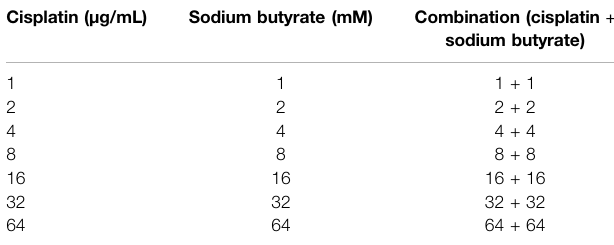
FIGURE1| EvaluationofGC cells ’ growthinhibitioninducedbycisplatin and/or sodium butyrate by CCK-8 kit. (A) (a) GC cells (HGC-27, SGC-7901 and MGC-803) were treated with cisplatin (0, 1, 2, 4, 8, 16, 32, and 64 µg/ml) or sodium butyrate (0, 1, 2, 4, 8, 16, 32, and 64 mM) for 24 h. (b) Cell Counting Kit-8 assays showed that HGC-27 cells and SGC-7901 cells were more sensitive to sodium butyrate. (c) GES-1 cells were treated with the different concentrations of cisplatin or sodium butyrate as described above and acombinationofcisplatin andsodium butyrate for24 h. (B) HGC-27 cells and SGC-7901 cells were treated with cisplatin and a combination of cisplatin and sodium butyrate (0.5 mM) for 24 h, respectively. (C) HGC-27 cells and